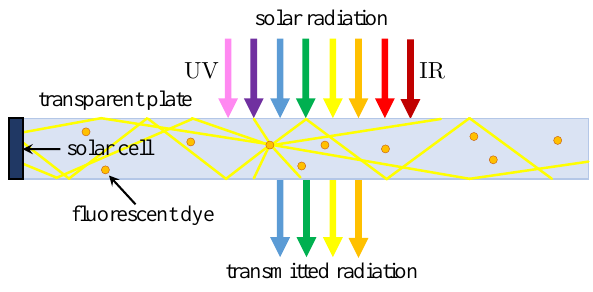
Figure 7. The basic construction of LSC with solar cell located on one side